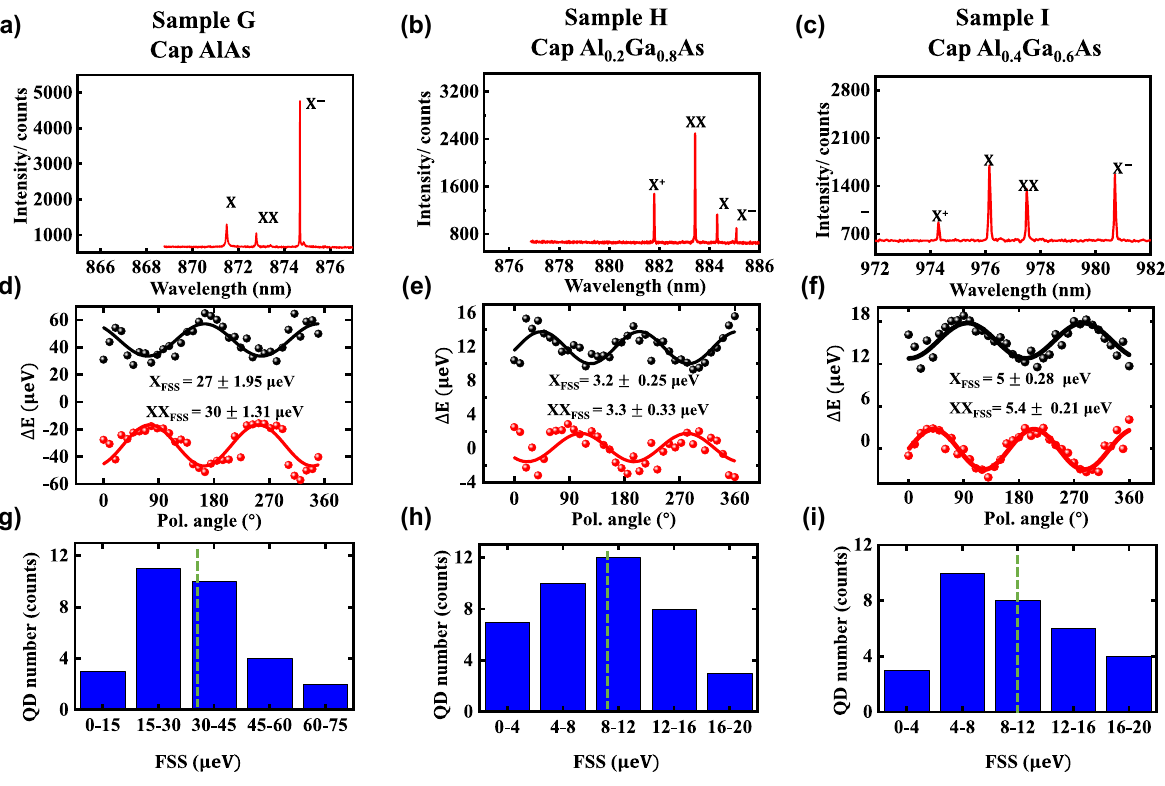
Figure 5: Optical properties of samples G – I. (a – c) Representative PL spectra of single QDs from samples G – I under above-band excitation; (d – f) the relative emission energy obtained by Lorentzianfitsofthespectrain(a – c)asafunctionofpolarizationangles.TheFSSvaluesareobtainedfromtheamplitudeofasinefitting.(g – i) The FSS histogram of X lines from samples G – I, the green dash lines represent measured mean FSS values of X line of each